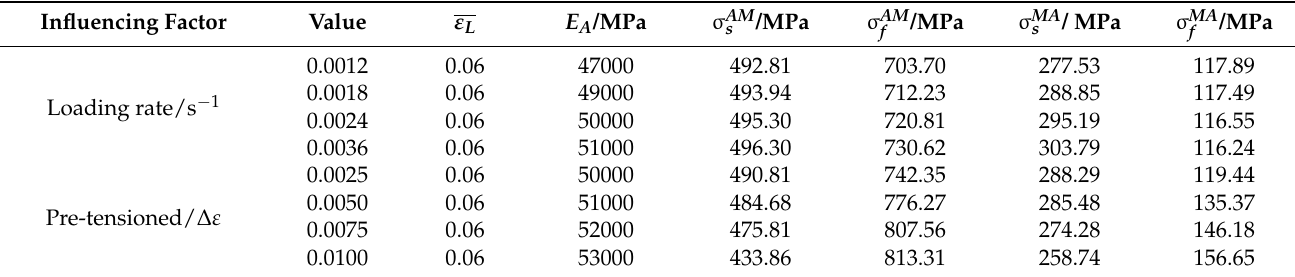
Figure 5. Constitutive model of SMA wire [22]. Table 2. Main parameters of SMA wire with different influencing